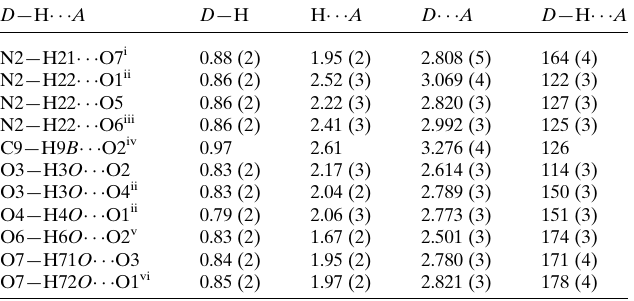
Table 10 Hydrogen-bond geometry (A˚ , (cid:5) ) for 11 .